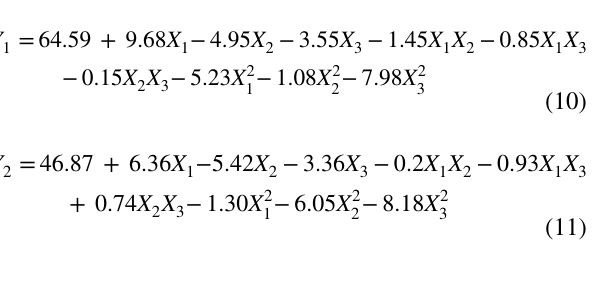
Table 4 Sequential model sum of squares and model summary statistics for percentage color removal (%)